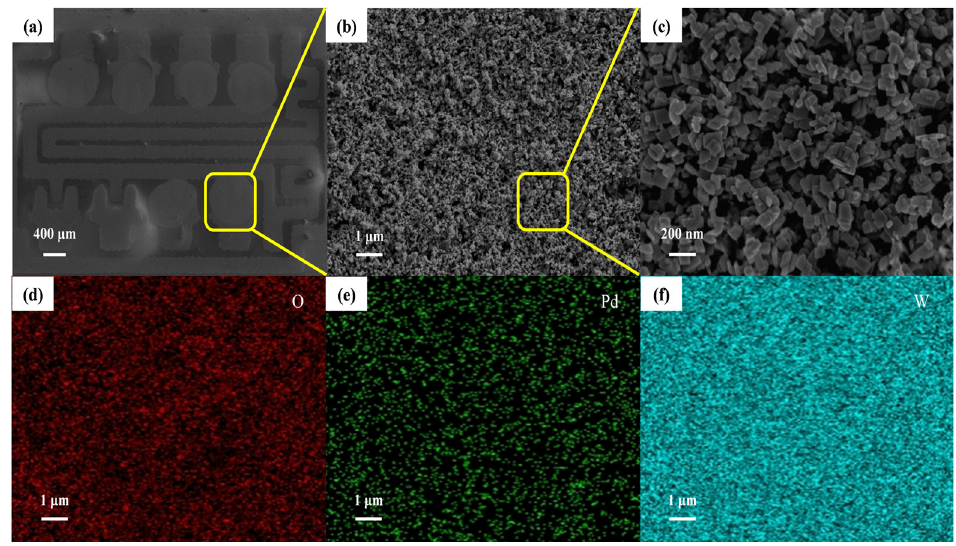
Figure 5. ( a ) Macroscopic photographs of gas-sensing films, ( b ) a microscopic magnification of the yellow underlined region in ( a ), ( c ) a microscopic magnification of the yellow underlined region in ( b ) and EDS mapping of WO 3 -0.5 mol% Pd film: ( d ) O, ( e ) Pd, ( f )